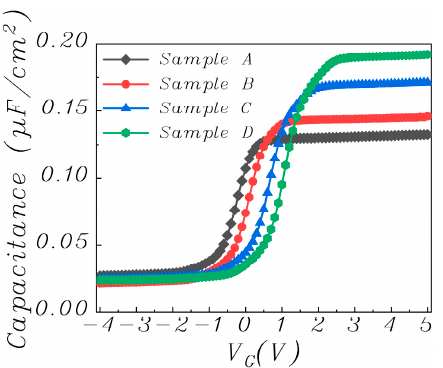
Figure 6. Capacitance-voltage characteristics of the capacitors with increasing Ti content in dielectric from Sample A to Sample D.